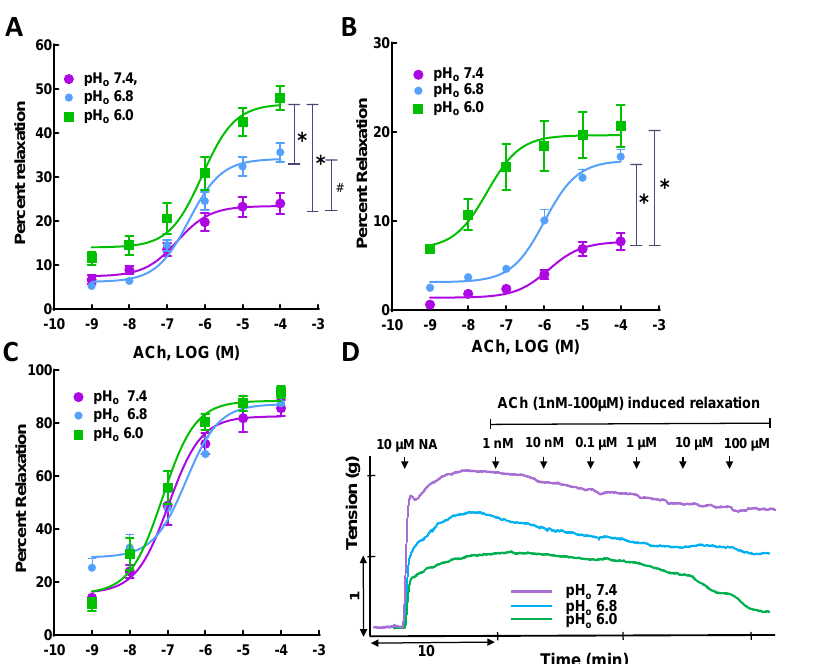
Figure 2. Effect of acidosis on vasorelaxation in superior mesenteric artery (SMA). Ach-induced vasorelaxation in ( A ) noradrenaline- and ( B ) KCl-precontracted SMA rings at pH o 7.4 is augmented at acidic pH o (6.8 and 6.0); ( C ) SNP-induced vasorelaxation in NA-precontracted SMA rings did not differ significantly at pH o 7.4, 6.8, and 6.0; representative tracing showing ( D ) Ach-induced vasorelaxation in NA-precontracted SMA rings at pH o 7.4, 6.8, and 6.0. This suggests endothelium plays a pivotal role in acidosis-mediated relaxation in SMA. * p < 0.05 vs. normal pH o (7.4) and # p < 0.05 vs. mild acidic pH o (6.8), n = 5–9.